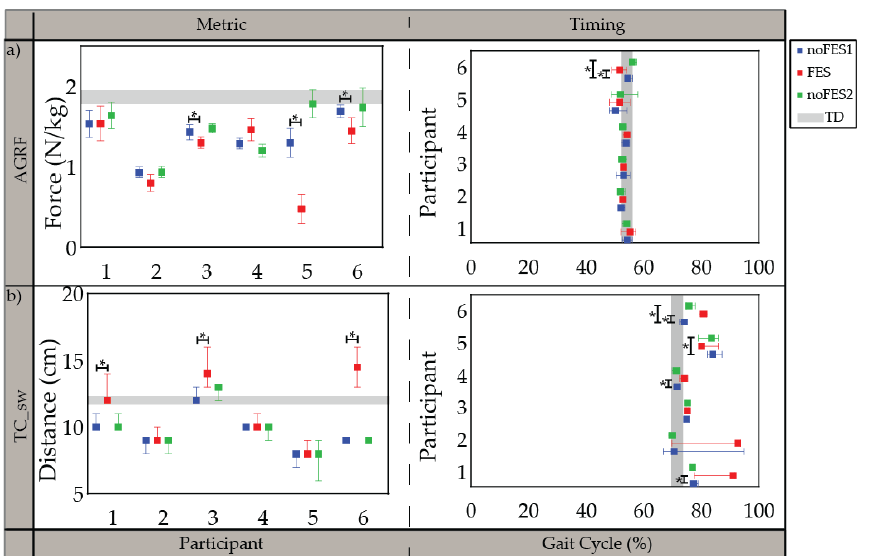
Figure 2. Median and 95% confidence interval (CI) of gait metrics targeted by all individualized stimulation programs and timing of gait metrics (percent of gait cycle) during noFES1 (blue) , FES (red) , and noFES2 (green) walking conditions. ( a ) peak propulsive force ( AGRF ) and ( b ) minimum toe clearance in swing period ( TC_sw ). Gray band represents 95% CI for typically developing reference dataset ( TD ). * indicates significance between walking